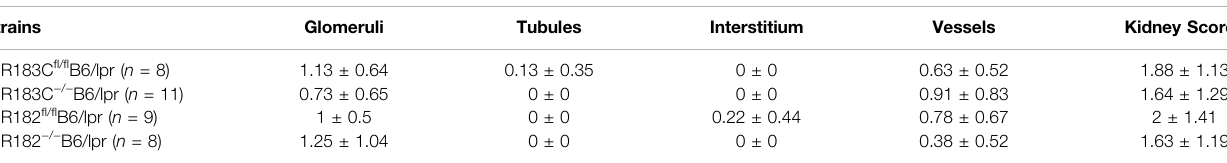
TABLE 2 | Renal histopathological scores.